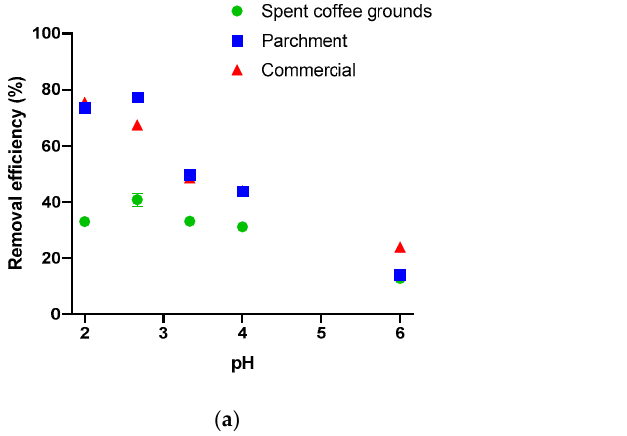
Figure 4. Effect of lactic acid adsorption onto spent coffee grounds, parchment, and commercial activated carbon. ( a ) Different initial pH (2–6) with 2.5 g/L of lactic acid in the bulk solution, adsorbent dose of 10% ( w / v ) and 4 h contact time at room temperature; ( b ) different initial lactic acid concentrations (0.5–25 g/L) without pH correction, adsorbent dose 10% ( w / v ) and 4 h contact time at room temperature. Data are expressed as means ± standard deviation ( n = 3). Analysis of the variance two ‐ way ANOVA, p < 0.05, Tukey’s test.